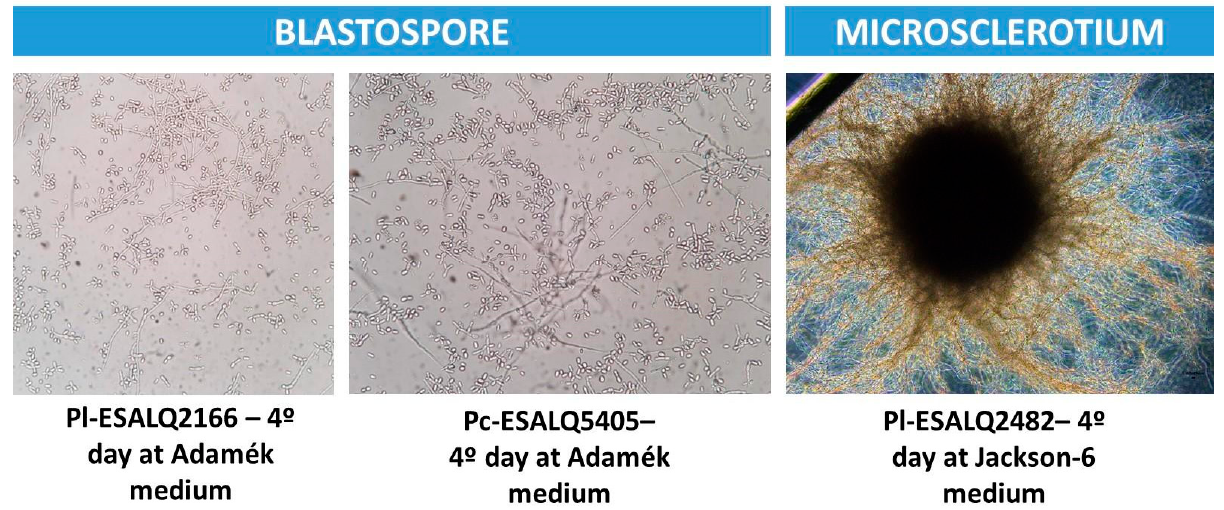
Figure A1. Typical fungal propagules (blastospore and microsclerotium) produced by submerged liquid culture after four days of cultivation using shake flasks (50 mL of liquid medium and 300 rpm of agitation speed).